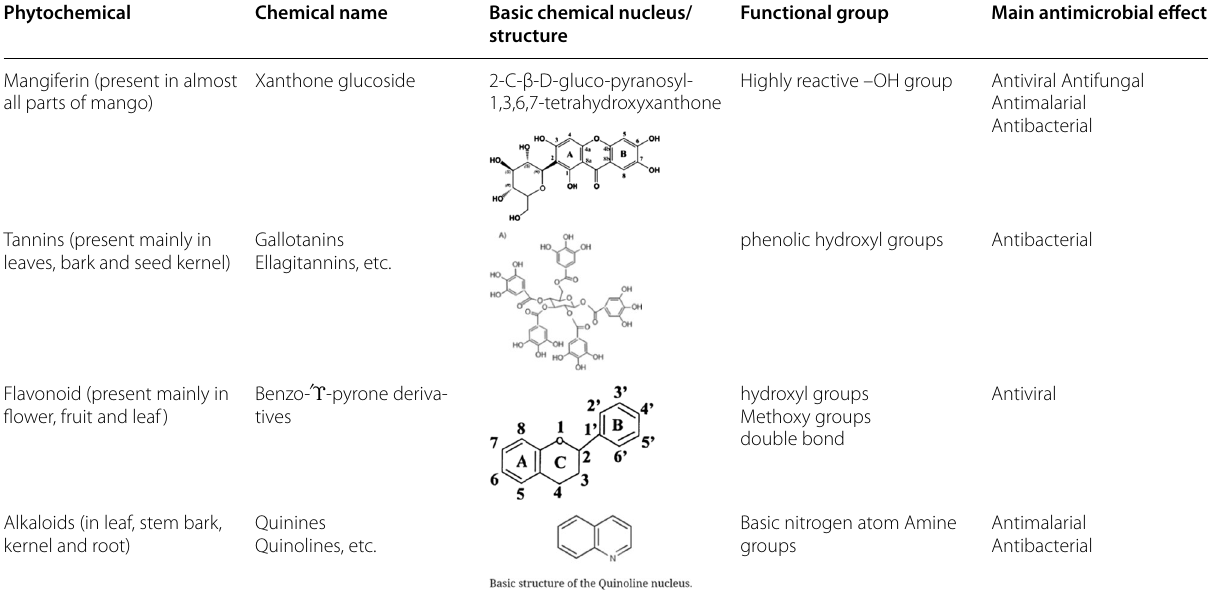
Table 5 Antimicrobial activity, functional group and basic nucleus/structure of some selected phytochemicals in mango